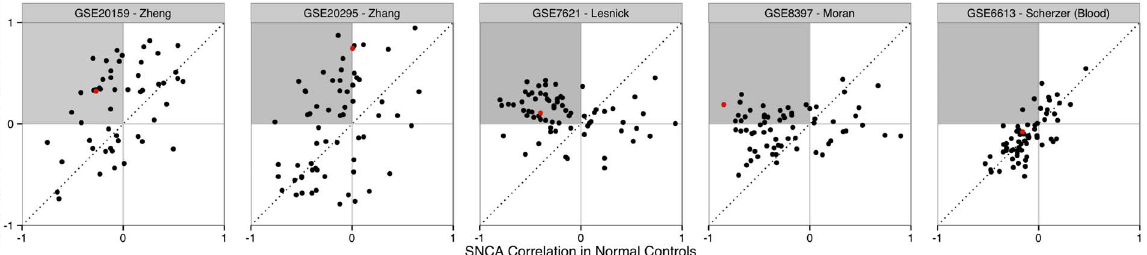
Fig. 3. Scatterplot of SNCA co-expression with IFN- c genes in five Parkinson’s studies. The first four studies assayed post-mortem substantia nigra samples with the final plot [14] showing co-expression results from blood. Genes switching from negative co-expression in normal controls to positive correlation in PD cases are highlighted in the shaded quadrant. The red point marks the IFNGR1 gene, which has the strongest change in co-expression in the substantia nigra